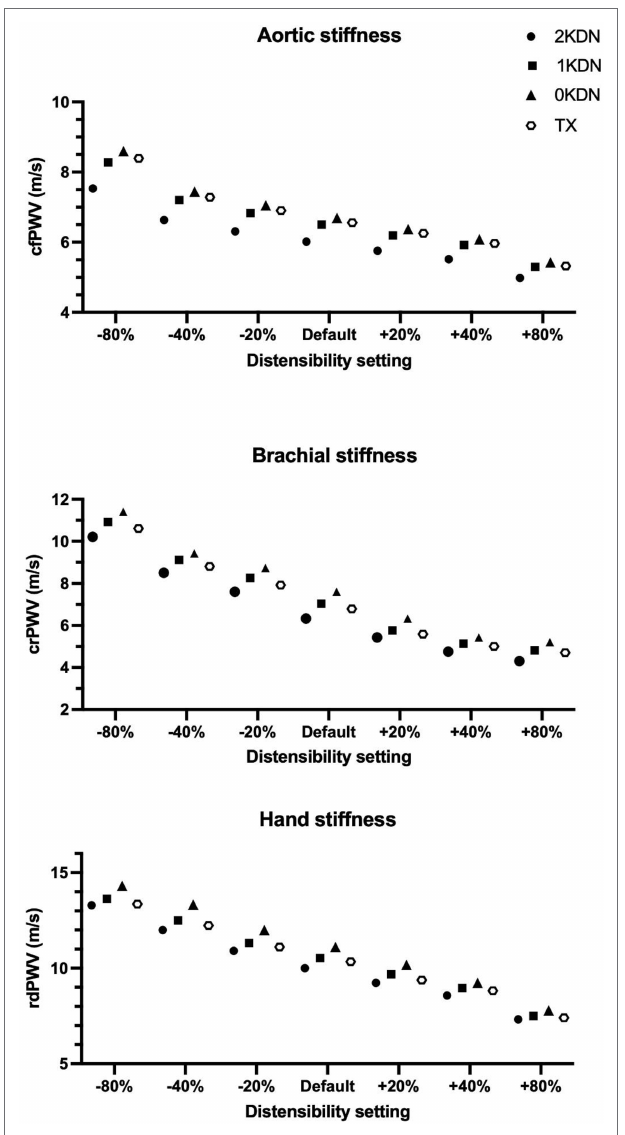
FIGURE 8 | Regional arterial stiffness (AS) with varying degrees of distensibility per renal disease status simulation ( in silico